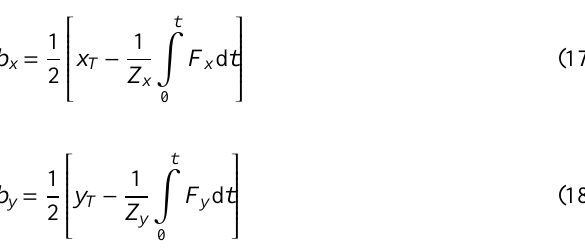
Figure 4. WBC plan for gantry crane with planar-moving